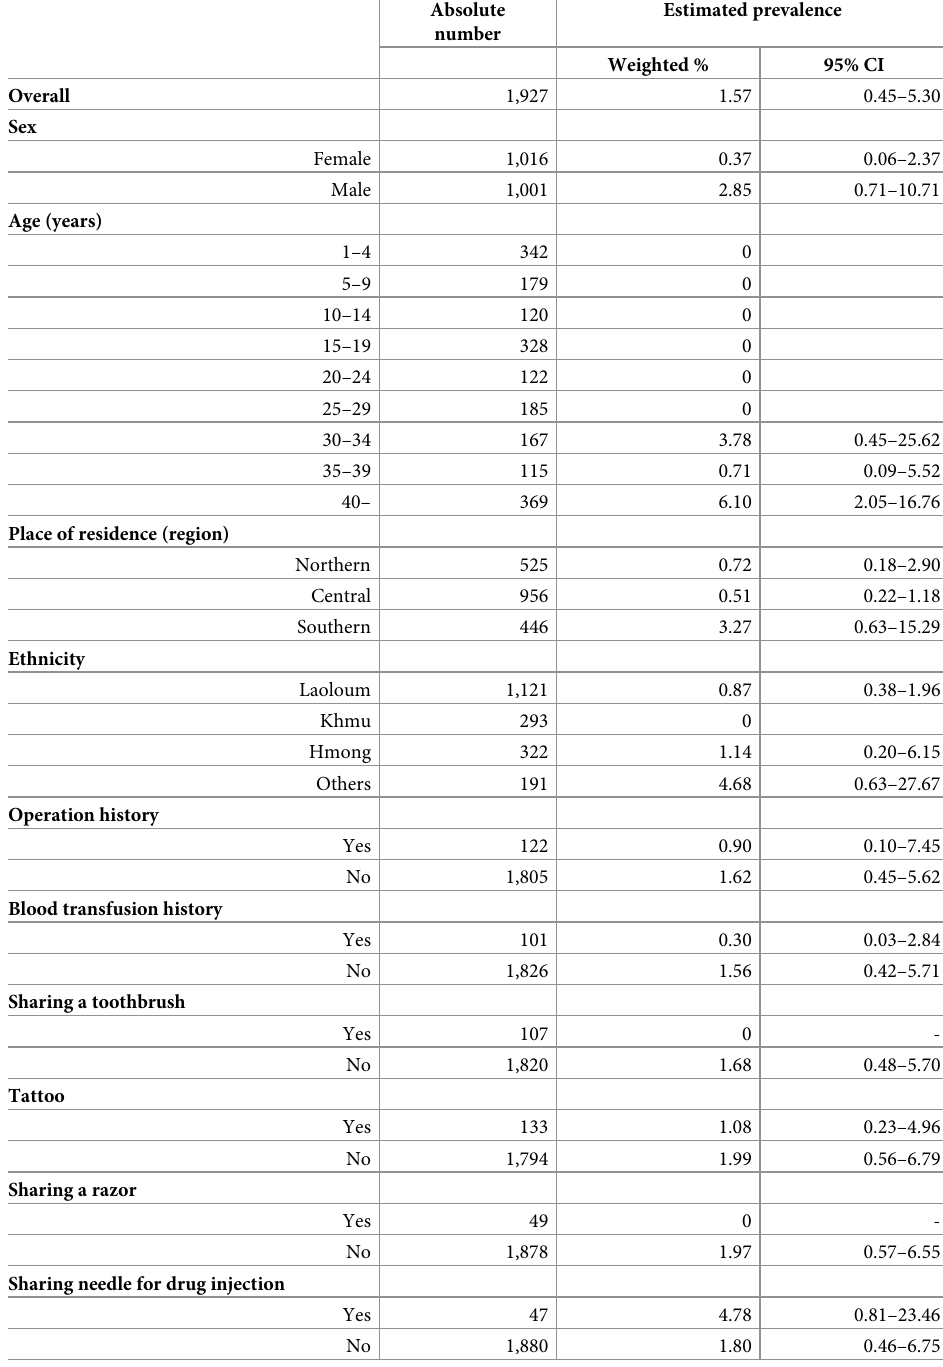
Table 3. Estimated prevalence of